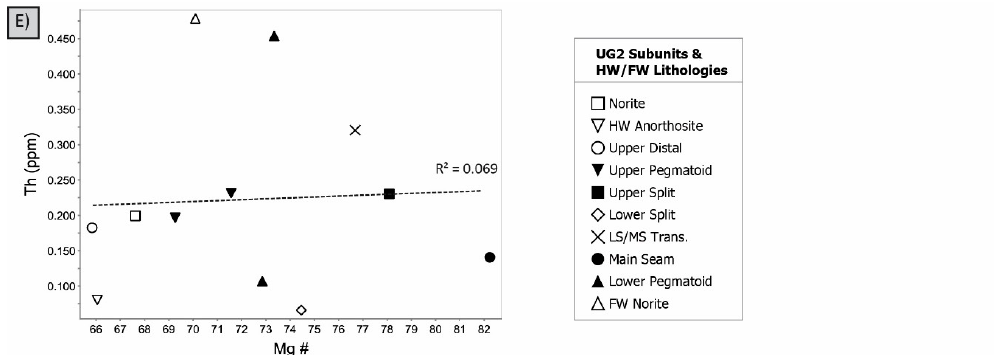
Figure 11. Average trace element concentrations of orthopyroxene ‘core’ ROI versus average Mg#s for each sampled depth interval. Outliers, which were rejected in the trend line fit, are highlighted in red. ( A ) Chromium/Mg# plot; ( B ) Nickel/Mg# plot; ( C ) Vanadium/Mg# plot; ( D ) Yttrium/Mg# plot; ( E ) Thorium/Mg# plot.